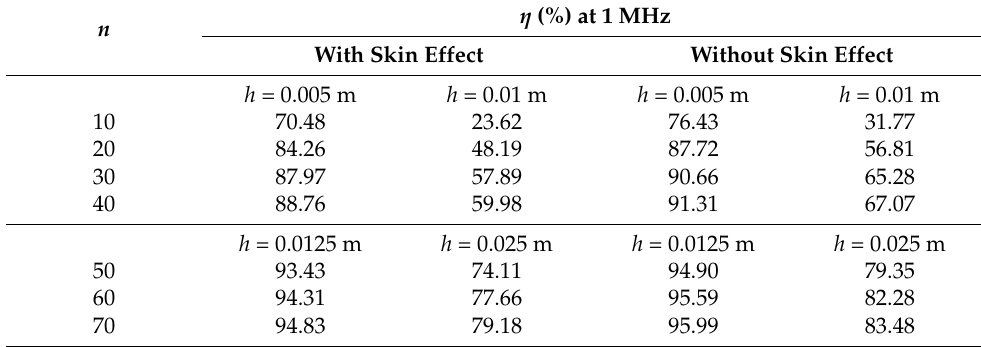
Table 6. Maximum power transfer efficiency values at 1 MHz. n